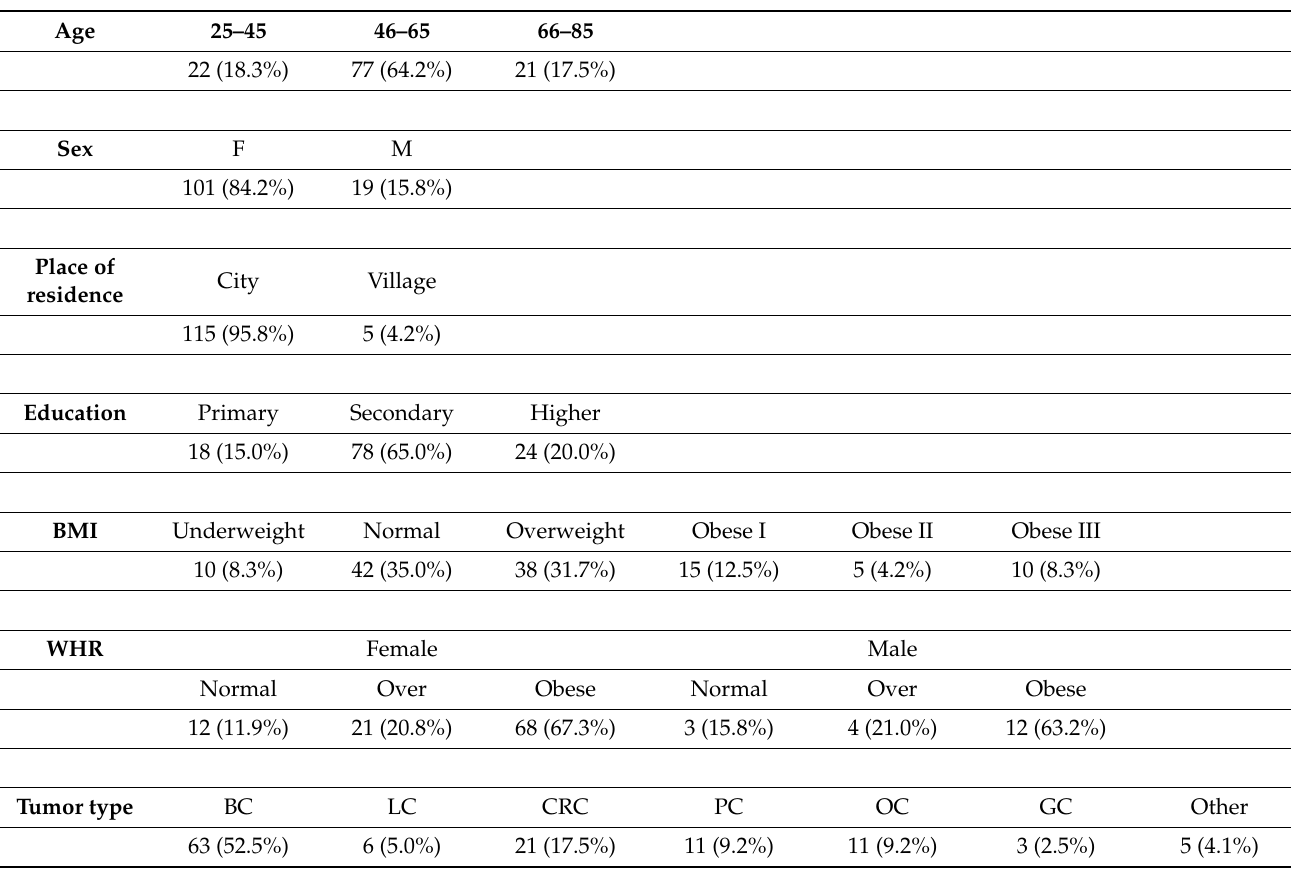
Table 1. Patients recruited for the study: descriptive